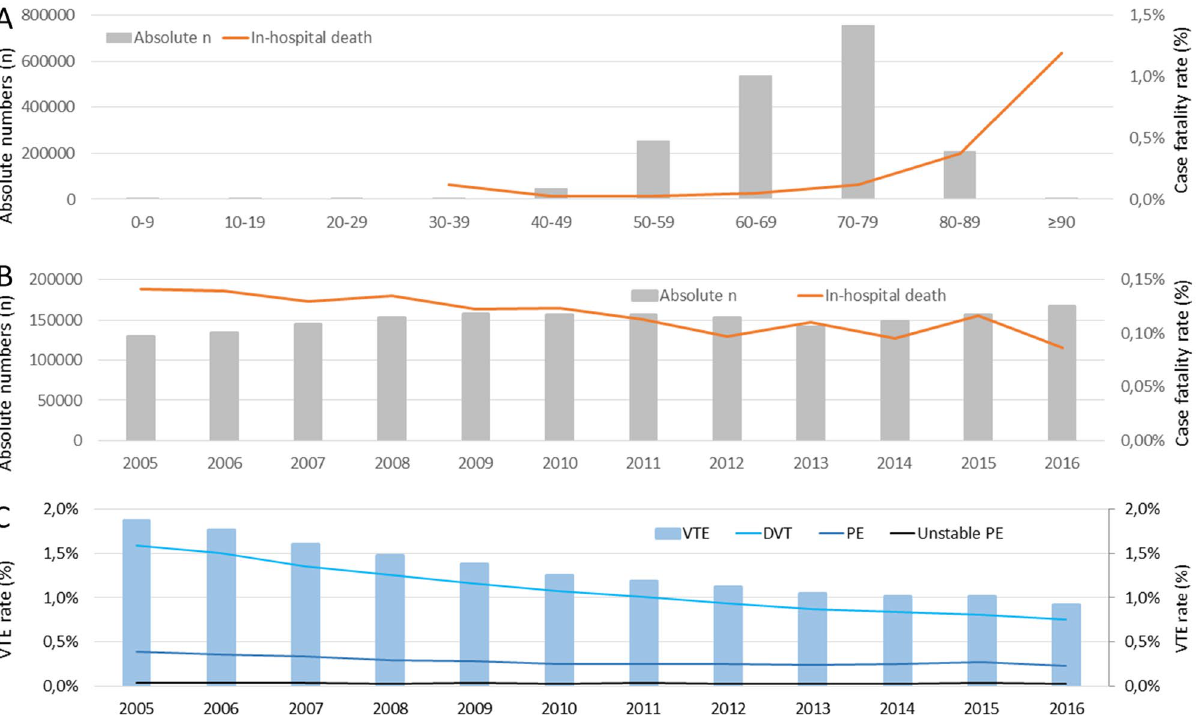
Figure 1. Time trends in absolute number of hospitalizations, in-hospital mortality and VTE rate in patients undergoing elective primary KJR in Germany from 2005 to 2016. ( A ) Total numbers of patients undergoing elective primary KJR (grey bars) and in-hospital death rate (orange line), stratified per decade of age, over the entire period 2005–2016 (cumulative data). ( B ) Annual total numbers of patients undergoing elective primary KJR (grey bars) and corresponding annual in-hospital death rates (orange line) in Germany in the period 2005– 2016. ( C ) Percentage of patients undergoing elective primary HJR who developed in-hospital VTE (light blue bars); the panel further shows percentage of deep vein thrombosis and thrombophlebitis (DVT, light blue line), pulmonary embolism (PE, admiral blue line), and high-risk PE with hemodynamic instability (dark blue